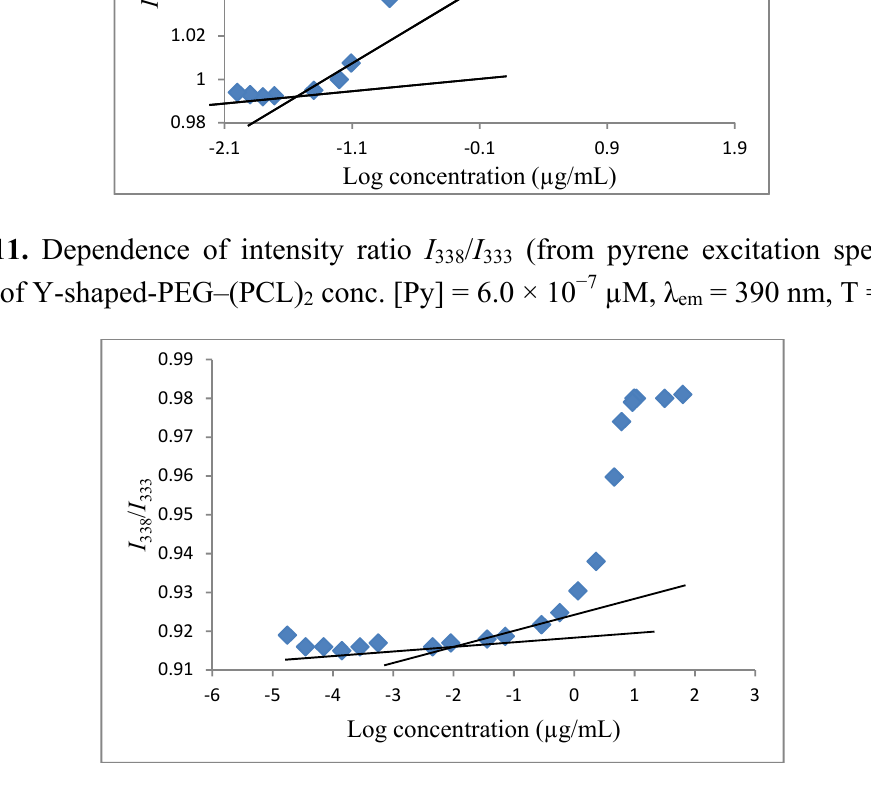
Figure 10. Dependence of intensity ratio I function of star-(PCL- b -PEG) T = 37 °C.